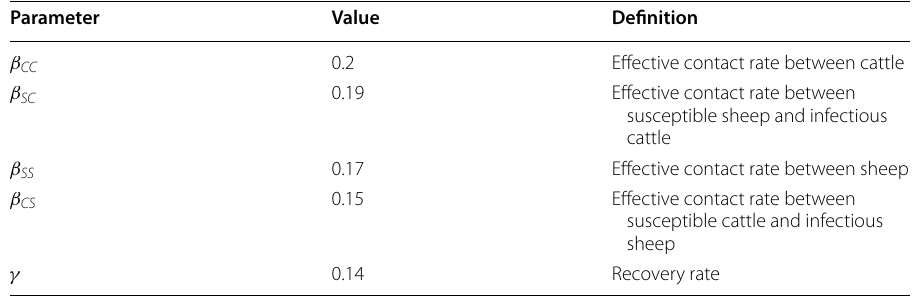
Table 3 Daily rates for the parameters in the simulation model